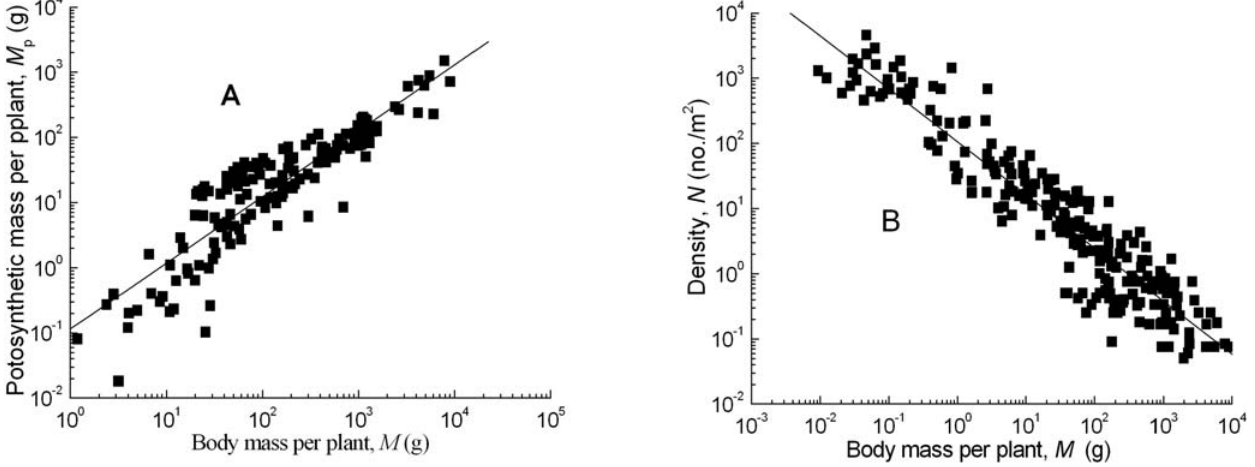
Figure 1. The allometric relationships between photosynthetic mass and body mass (A), and population density and body mass (B) for desert shrubs. All regressions are significant at P , 0.0001 and the 95% CI of the slopes are statistically different from 3/4 and 2 3/4 (also see Table 1, 2), but the ratio of the two exponents is not statistically different from 2 1. doi:10.1371/journal.pone.0001799.g001 PLoS ONE |